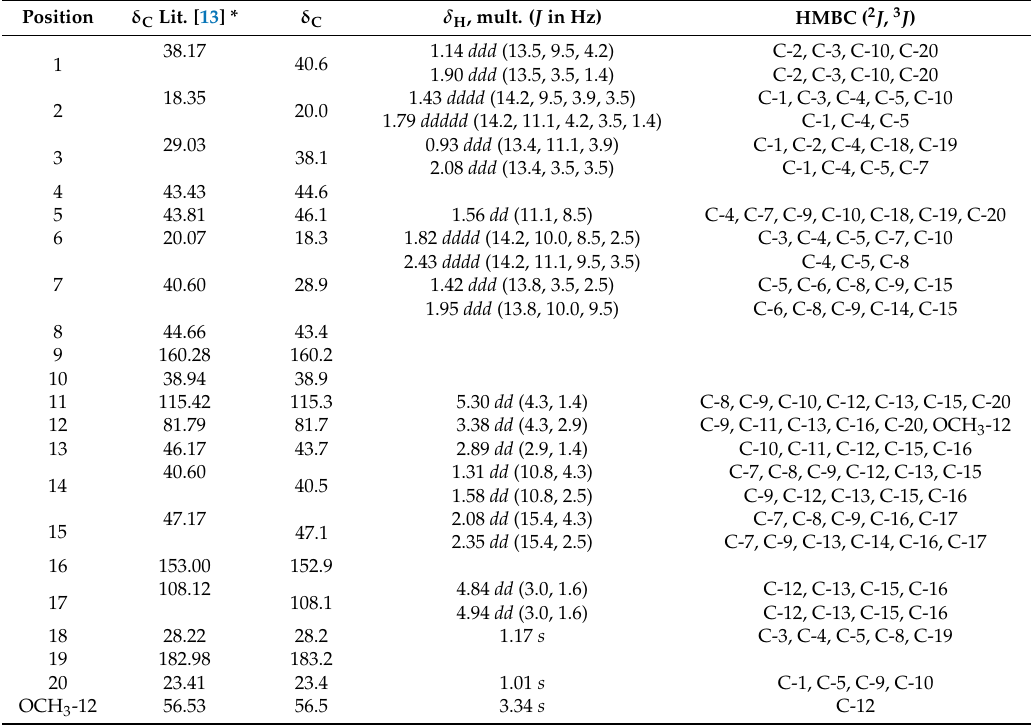
Table 1. The 1 H (800 MHz) and 13 C-NMR (200 MHz) data for compound 1 acquired in CDCl 3 .